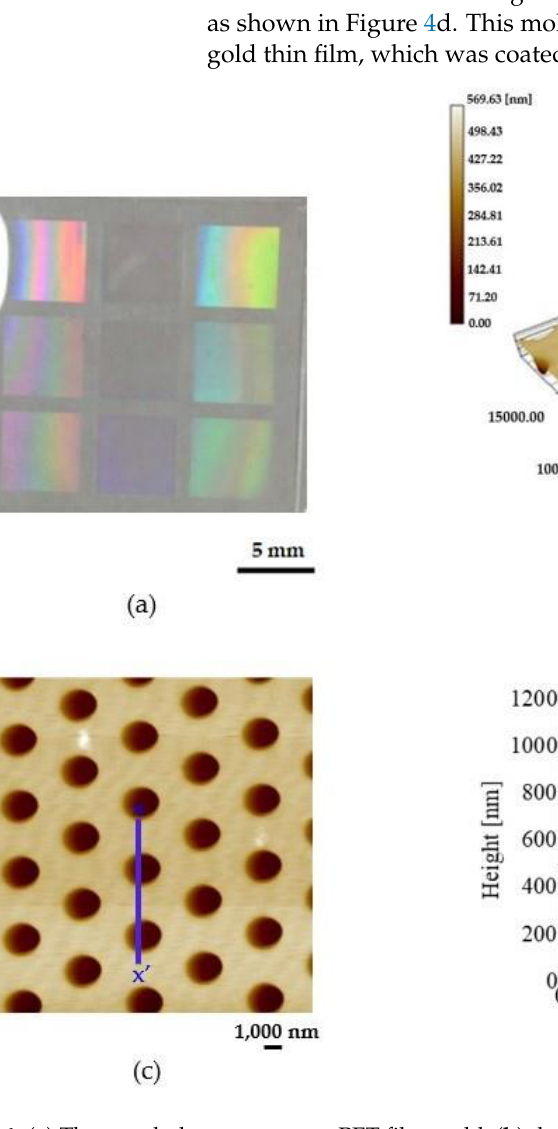
Figure 4. ( a ) The nanohole patterns on a PET film mold; ( b ) the three dimensional of AFM topography image; ( c ) the top view of AFM topography image; and ( d ) the height profiles.